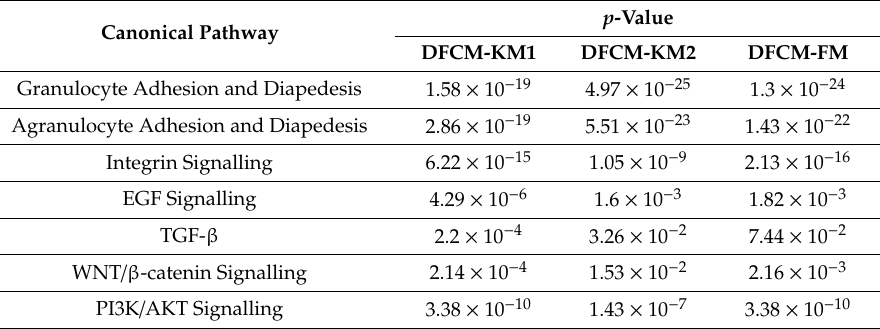
Figure 7. Graphic represents the interaction relationships for DFCM-FM. The mutual genes in the target network are displayed as nodes, and include collagen (ECM), PDGF (growth factor) and integrins (cell adhesion molecules), which activate the ERK/MAPK pathway. Red nodes indicate upregulated genes; green nodes indicate downregulated genes. Table 5. Pathway interaction analysis -generated canonical pathways involved in wound healing. The p -values represent the significance of the pathway.